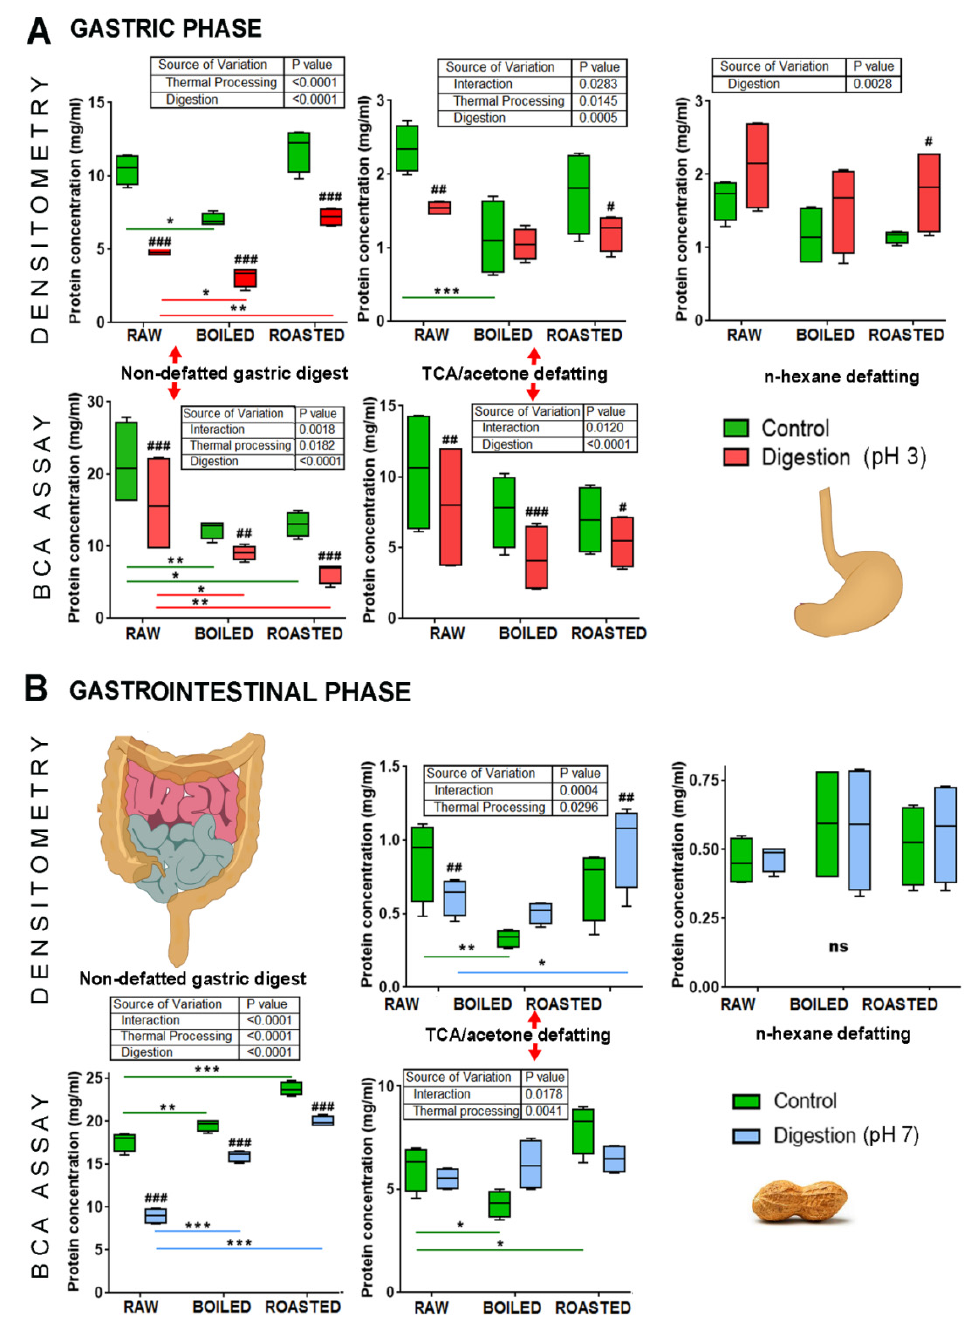
Figure 2. Averages of protein concentrations in different soluble phases of simulated peanut digestion. ( A ) Oral gastric phase protein content determined by BCA assay and densitometry tests, before and after defatting with n-hexane and trichloroacetic acid (TCA) precipitation. ( B ) Gastrointestinal phase. A two-way matched ANOVA was used on at least two separately performed digestions; ns, not significant; #, ## and ###, significant difference of digested sample compared to its control ( p < 0.05, p < 0.005 and p < 0.0001, respectively). *, ** and *** denote significant difference of boiled or roasted peanuts in contrast to raw peanuts at p < 0.05, p < 0.005 and p < 0.0001, respectively. Adapted from Prodic et al., 2019 [19] .